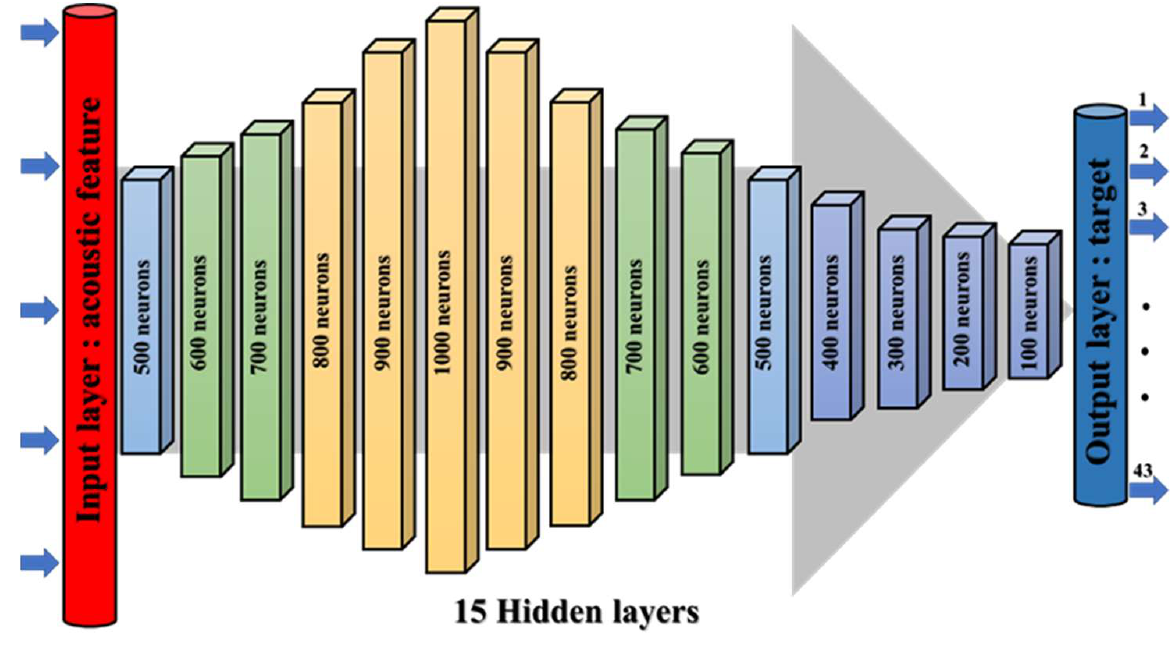
Figure 14. DNN architecture.